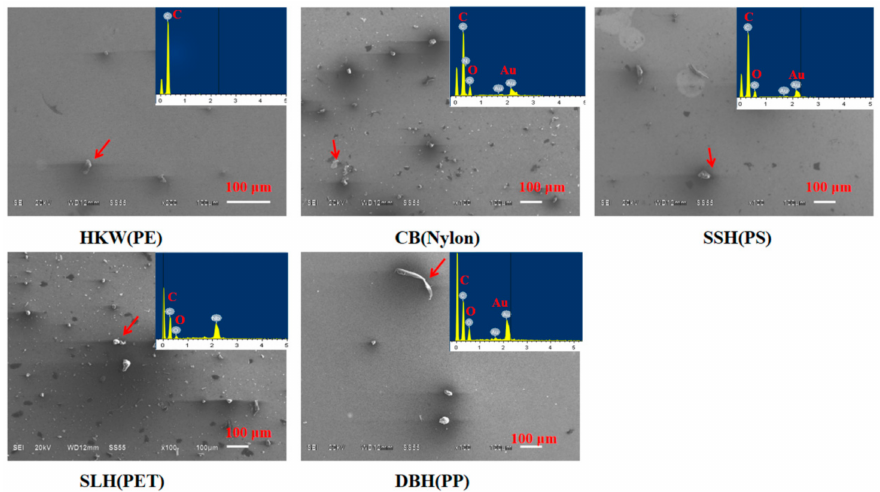
Figure 5. SEM Figures of microplastics contained in takeaway food